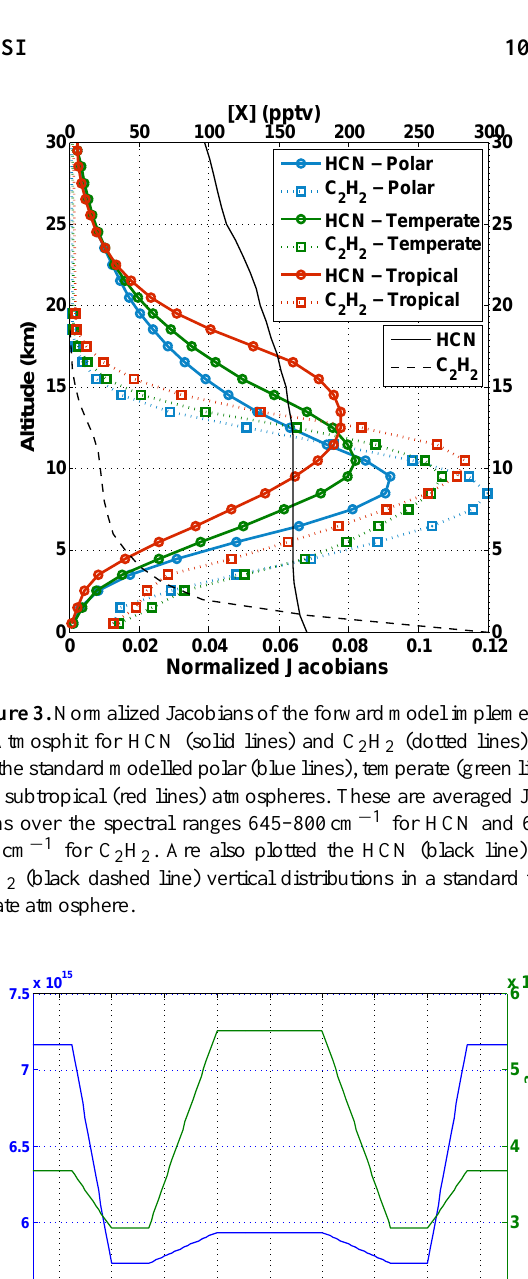
(green) as a function 2 H 2